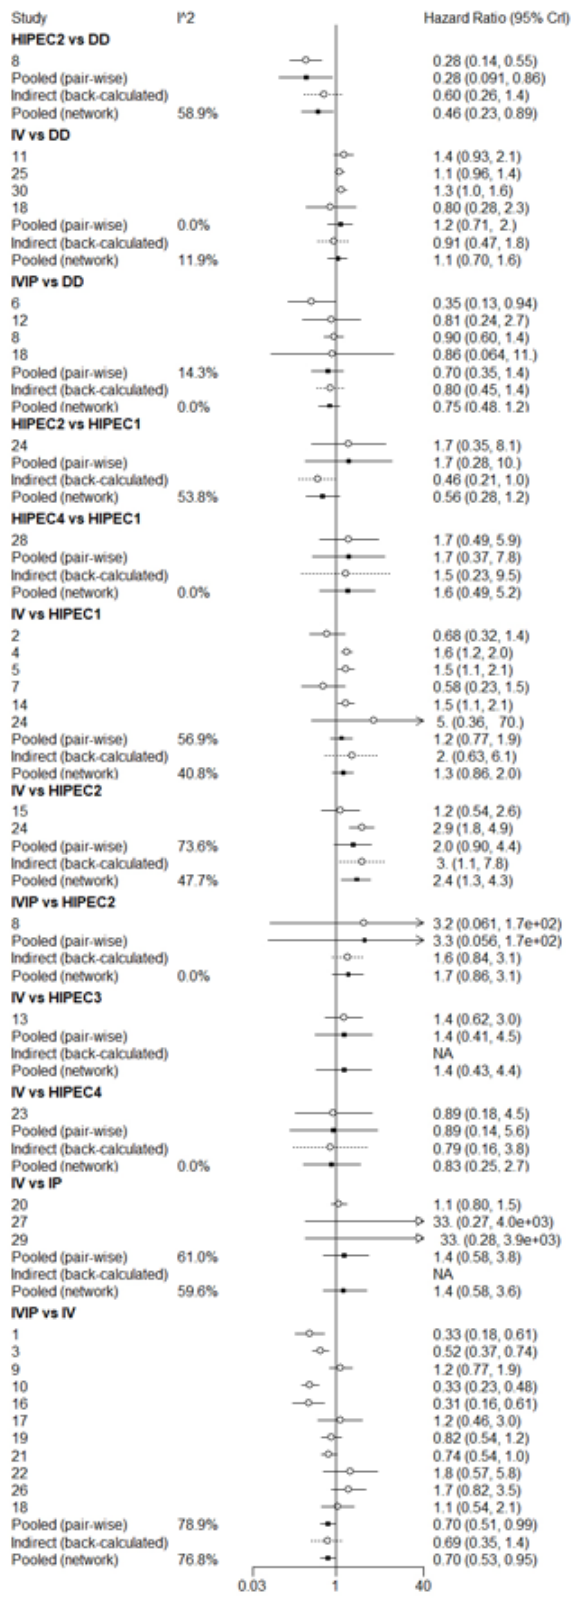
Figure A2. Forest plot of OS (non ‐ RCTs).